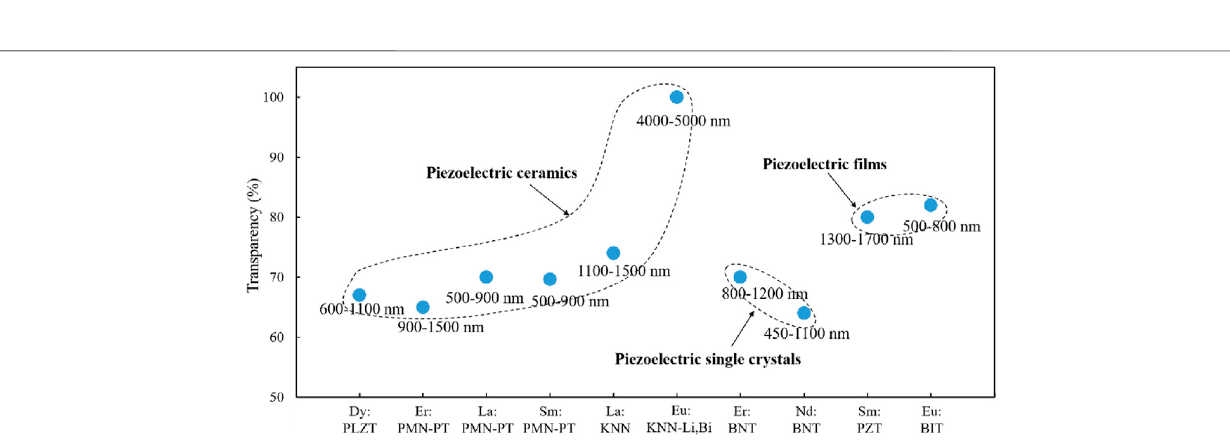
FIGURE 4 | The transmittance of some rare Earth doped piezoelectric materials in a certain wavelength range [with the thickness of 0.35 mm (Dy:PLZT); 0.6 mm (La:PMN-PT); 0.85 mm (Sm:PMN-PT); 0.5 mm (La:KNN); 0.5 mm (Eu: KNN-Li,Bi); 1 mm (Nd:BNT); 300 nm (Eu:BIT)] (Pandey et al., 2007; Ruan et al., 2008; Wei et al., 2012b; He et al., 2013; Zeng et al., 2014; Geng et al., 2017; Yang et al., 2017; Jiang et al., 2018; Ma et al., 2018; Fang et al.,